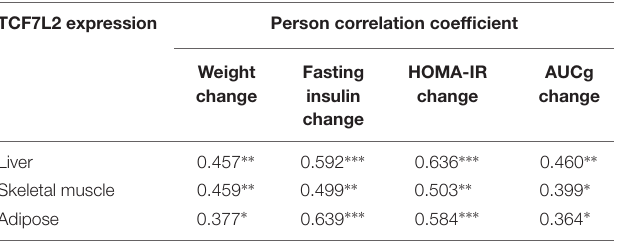
TABLE 2 | The correlation analysis between TCF7L2 protein expression and changes of metabolic measures. TCF7L2